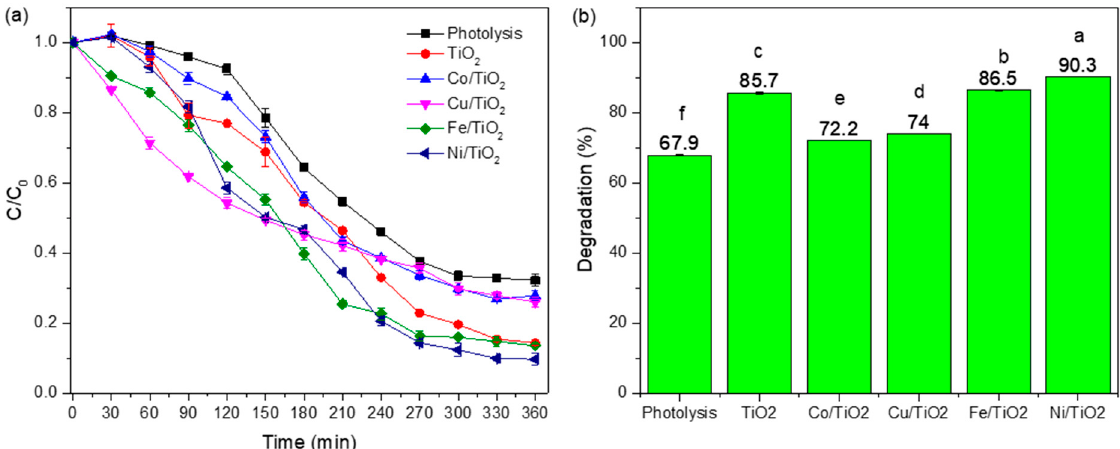
Figure 12. Degradation activity of 2,4-D ( a ) and percentage of degradation after 6 h of reaction ( b ). For the plot ( b ), all values are mean ± standard deviation of three determinations. Different letters in each column indicate significant statistical differences between treatments ( p < 0.05).